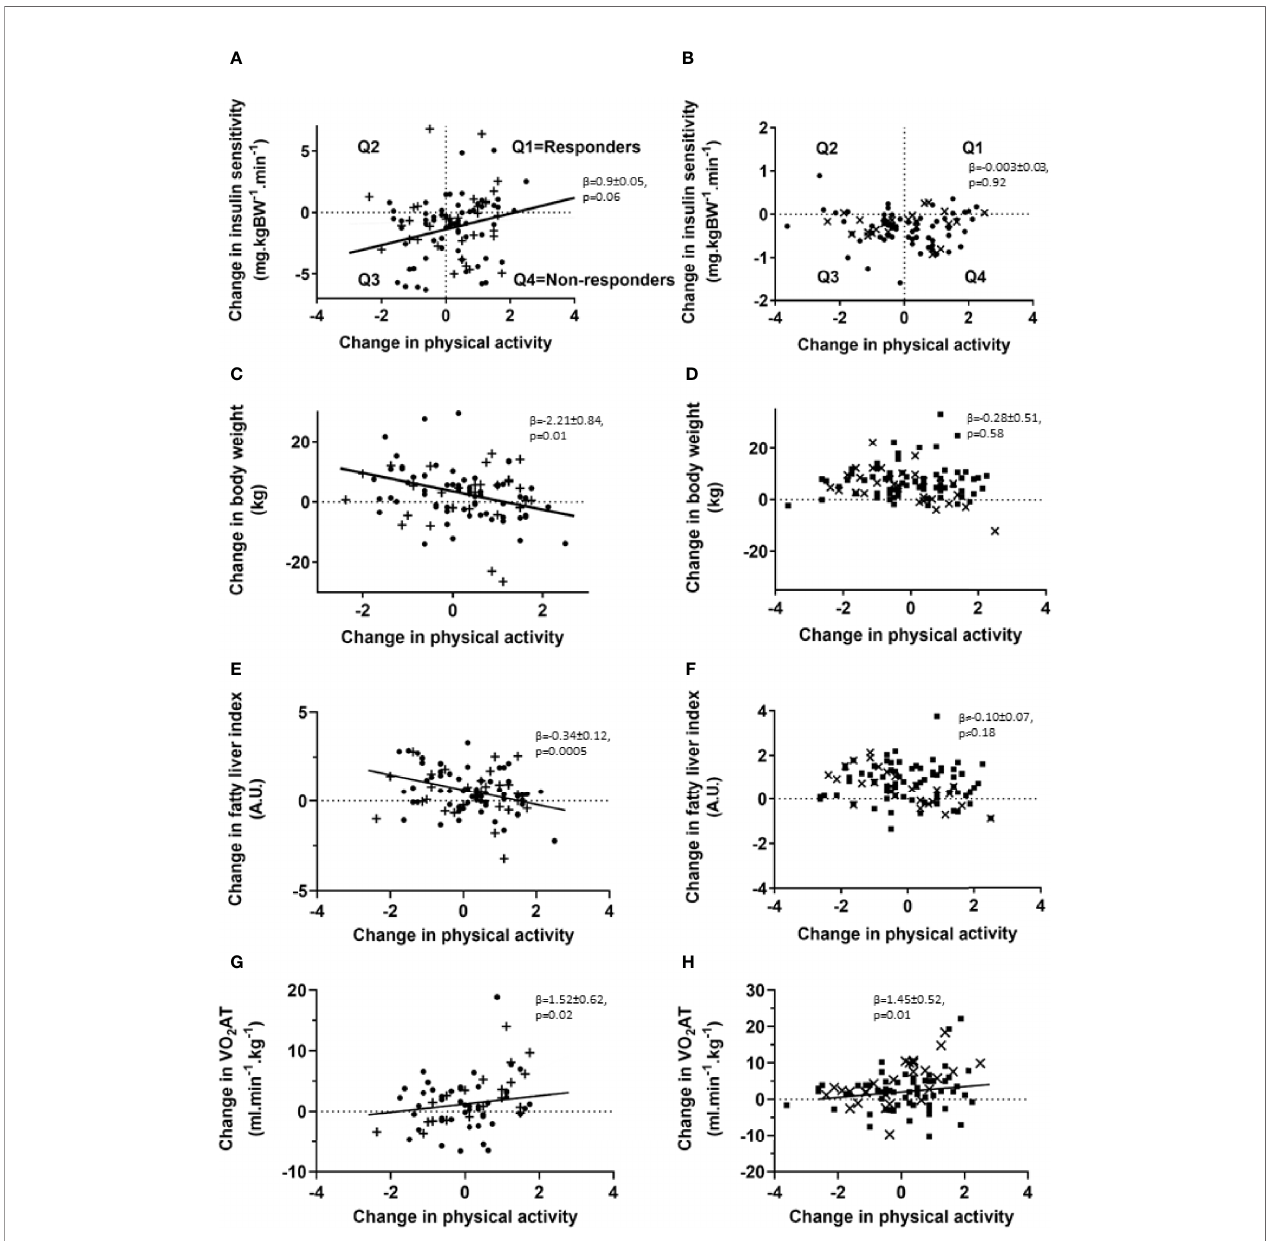
FIGURE 1 | Association of changes in PA levels and insulin sensitivity, body weight, liver fat estimates and exercise capacity in individuals with type 2 and type 1 diabetes. Association of changes in PA levels and insulin sensitivity (A, B) , body weight (C, D) , liver fat estimates (E, F) and physical performance (G, H) for patients with type 2 (left panel, (cid:129) – G/G allele carriers; + - G/A and A/A allele carriers) and type 1 diabetes (right panel, ▪ – G/G allele carriers; x – G/A and A/A allele carriers) at the 5-year follow-up time point. Patients with type 2 and type 1 diabetes were subdivided into four groups (Q1, Q2, Q3, Q4) based on response to changes in insulin sensitivity and PA levels. Univariate and multivariable linear least squared regression method was performed, adjusted for baseline values of both PA levels and the investigated clinical parameter. N=95 for changes in insulin sensitivity, N=95 for body weight changes and N=67 for performance changes in individuals with type 2 diabetes and N=100 for changes in insulin sensitivity, N=101 for body weight changes and N=90 for performance changes in individuals with type 1 diabetes.